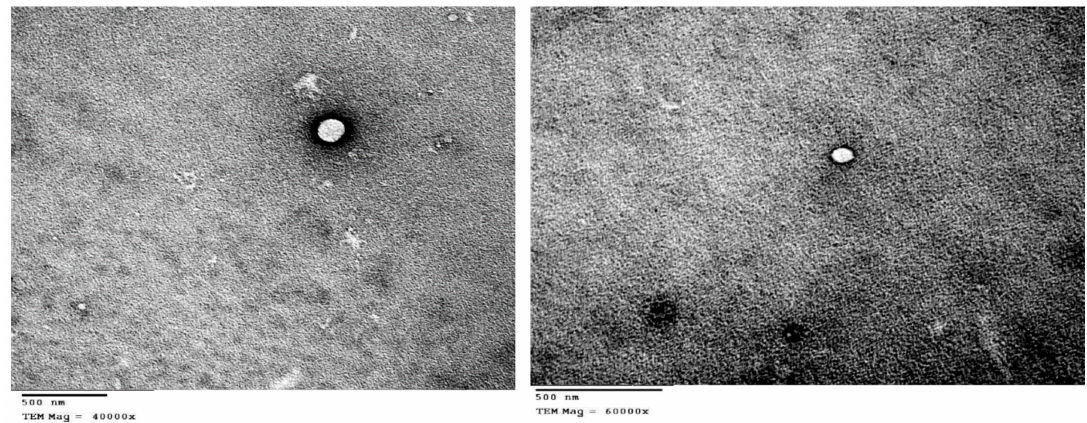
Figure 3. TEM photomicrograph of LeciPlex formulation